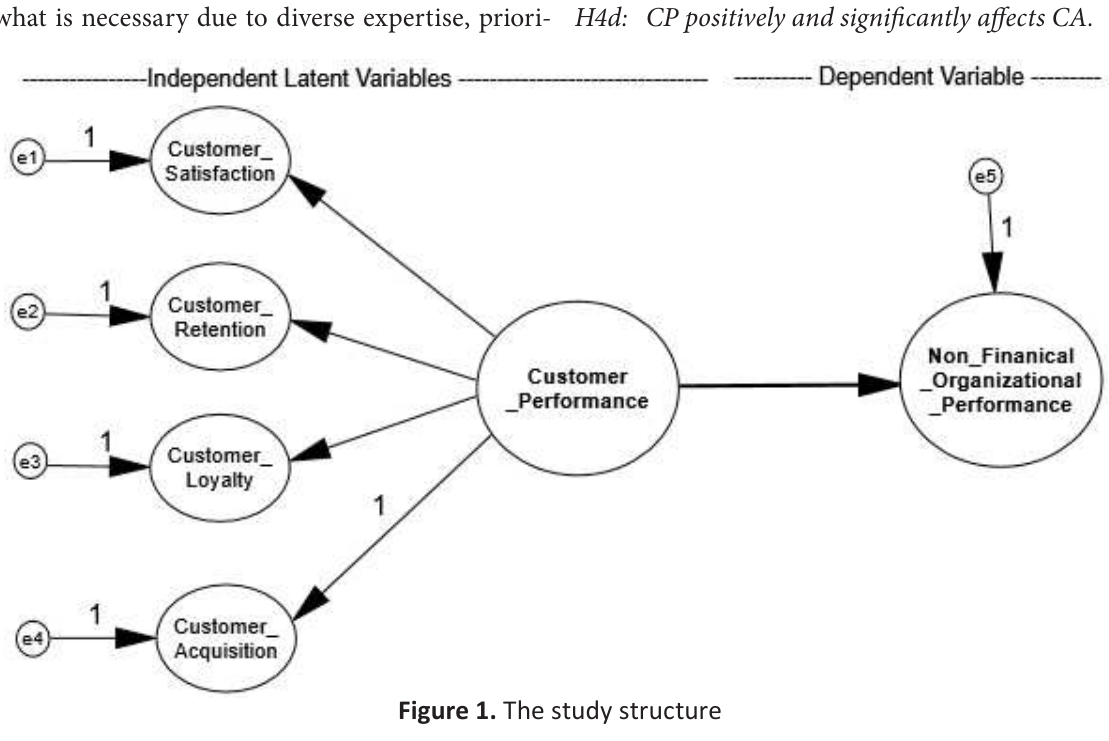
Figure 1. The study